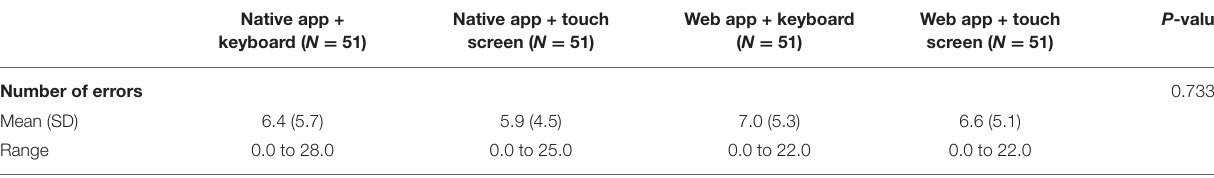
TABLE 5 | Average number of errors per participant vs. test type.